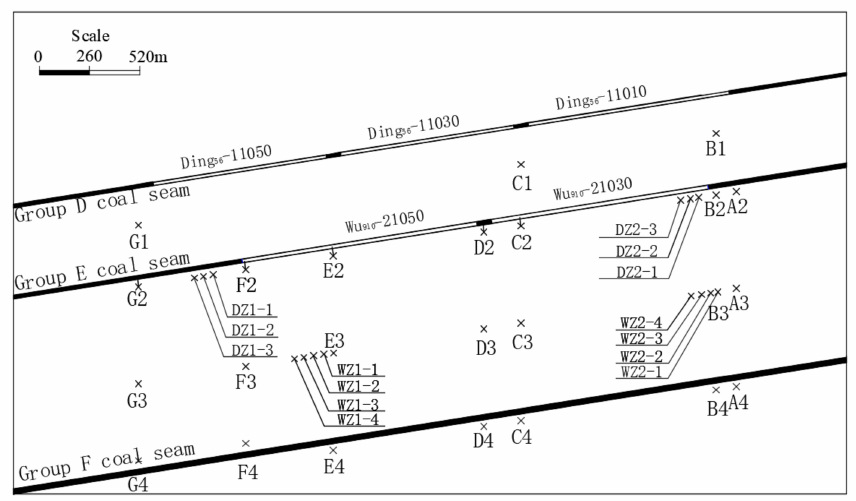
Figure 2. Arrangement of stress measurement points. The displacement monitoring points and stress monitoring points were, respectively, arranged in the model. The coding points were set on the experimental frame, drawing marker lines which were parallel to the seam or lead hammer on the front of the coal seam. The parallel lines were 3 cm from the top and bottom of the coal seam, respectively, and the rest of the parallel lines and lead hammer lines were spaced at 10 cm. The